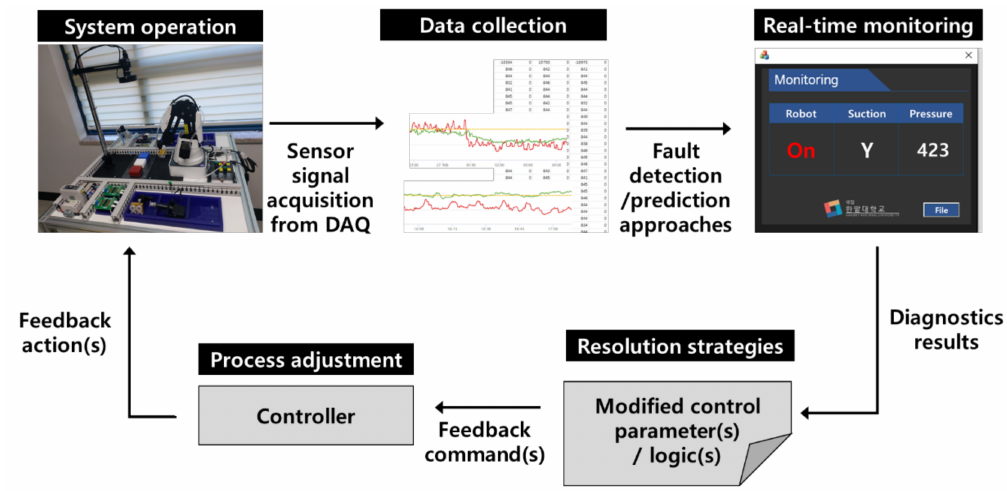
Figure 4. Framework of the predictive process adjustment method based on real-time data acquisition and feedback